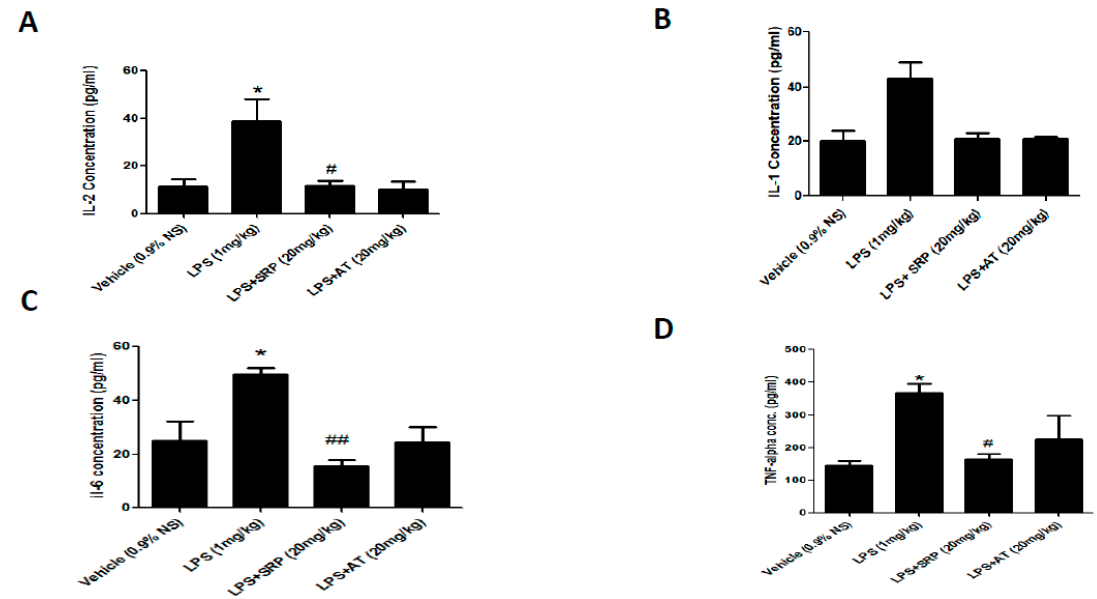
Figure 2. The effect of Serratiopeptidase on inflammatory biomarkers. Column figure shows the inflammatory biomarkers measured in whole aorta homogenates of vehicle control (0.9% NS), LPS-, LPS+SRP-, and LPS+AT-treated animals. ( A ) Interleukins-2; ( B ) interleukins-4; ( C ) interleukins-6; ( D ) TNF-alpha. Data represent mean ± SEM. n = 6 for each group. * represents significant values when compared to controls at p < 0.05, # represents significant values when compared to SRP-treated animals at p < 0.05, ## represents significant values when compared to LPS-treated group at p < 0.05.